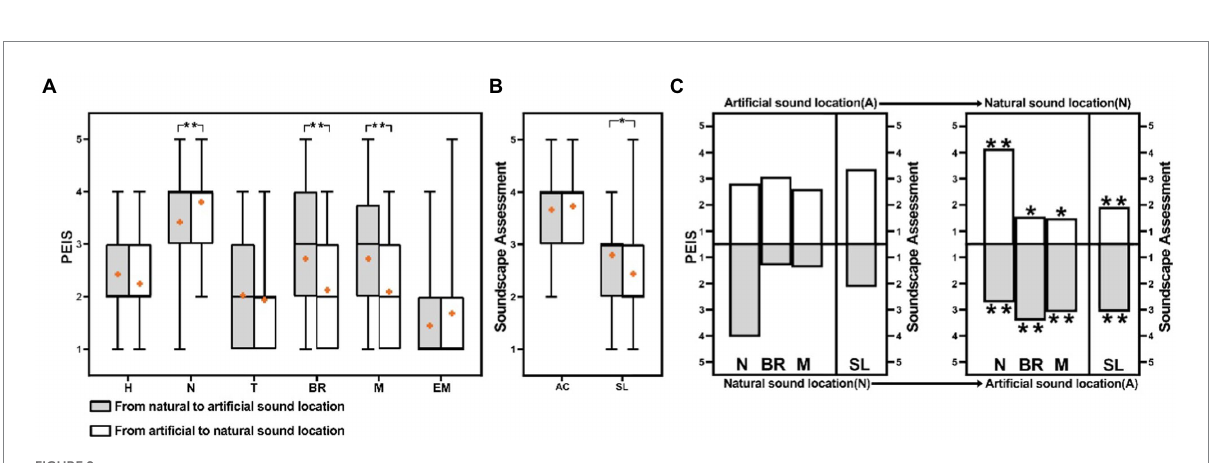
FIGURE 9 Comparison of PEIS and the soundscape assessment in sound source contrast paths: (A) Comparison of PEIS in sound source contrast paths, (B) Comparison of the soundscape assessment in sound source contrast paths, and (C) Comparison of each location PEIS and soundscape assessment in sound source contrast paths. (H, Human sound; N, Natural sound; T, Traffic noise; BR, Broadcast sound; M, Music; EM, Electro- mechanical sound; AC, Acoustic comfort; SL, Subjective loudness; * p < 0.05, ** p < 0.01; (C) : * p , ** p : correlation between PEIS of each location and overall PEIS, assessment of each location and overall